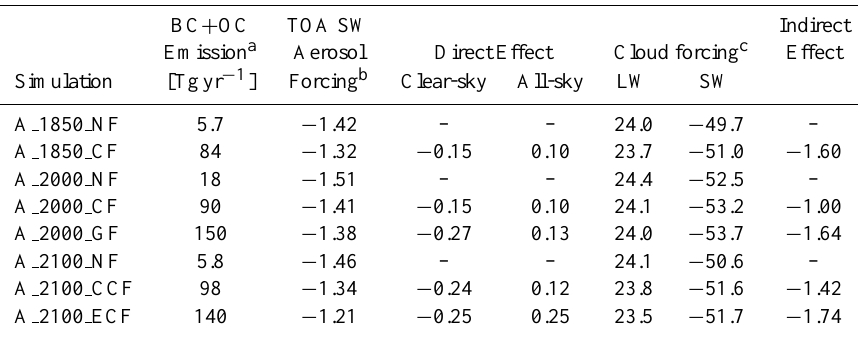
Table 5. Global annual average forcing terms for aerosols in all CAM5 simulations. All figures are given in Wm − 2 , except for the global, annual total BC and OC emissions. The indirect effects are equivalent to the change in LWCF added to the change in SWCF. BC + OC TOA SW